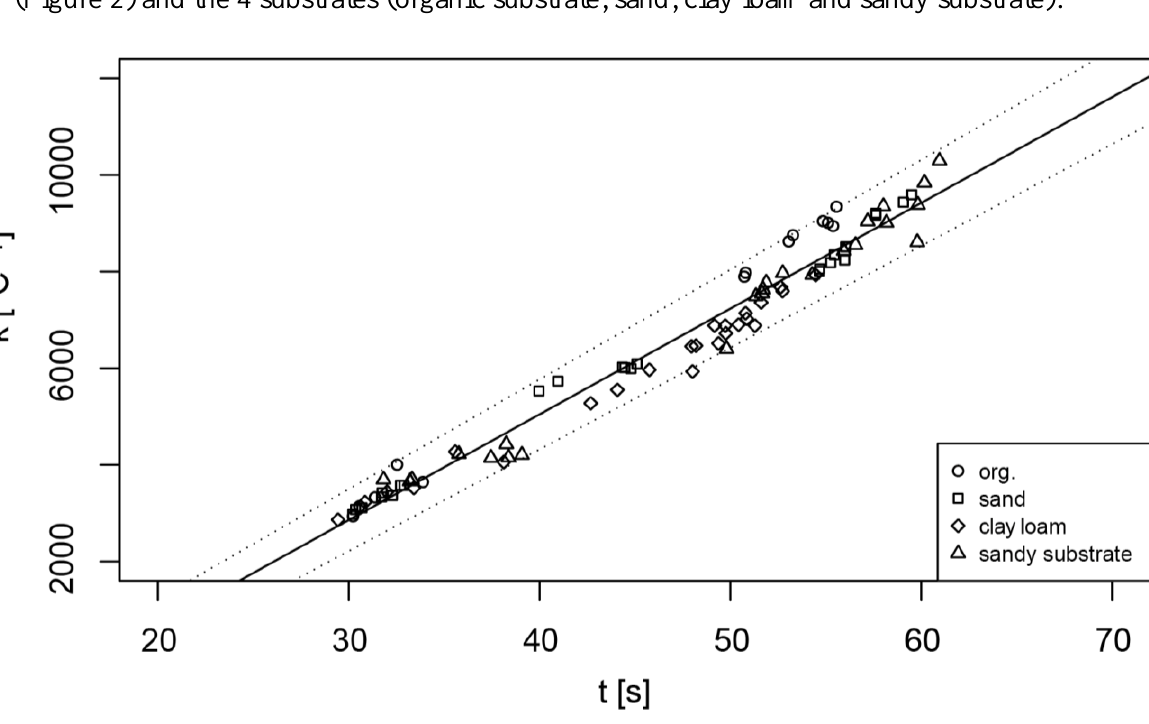
Figure 5. Correction factor k as a function of the cooling time t for a threshold value of